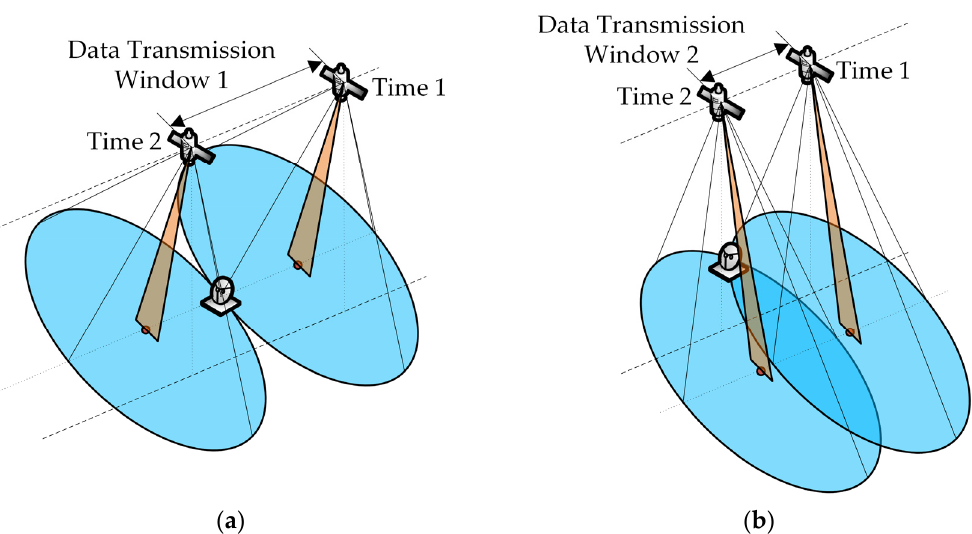
Figure 3. Schematic diagram of the data transmission window with different satellite attitudes. ( a ) Satellite attitude pointing to the ground station. ( b ) Satellite attitude not pointing to the ground station.